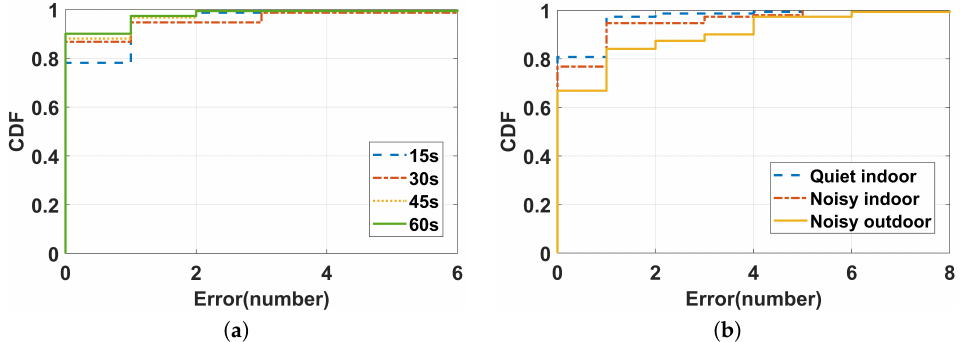
Figure 9. CDF of counting error with varied durations ( a ) (Performances for different durations) and environments ( b ) (Performance for different